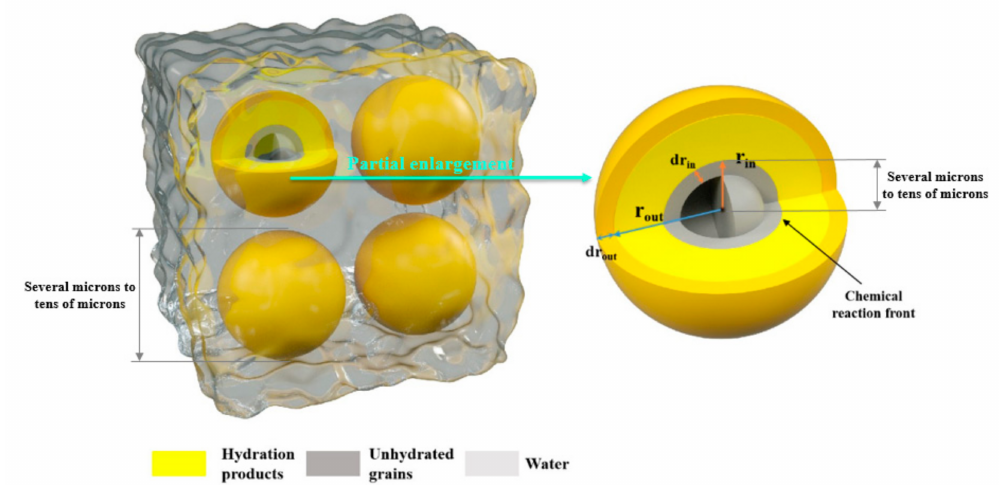
Figure 3. Schematic diagram of particle